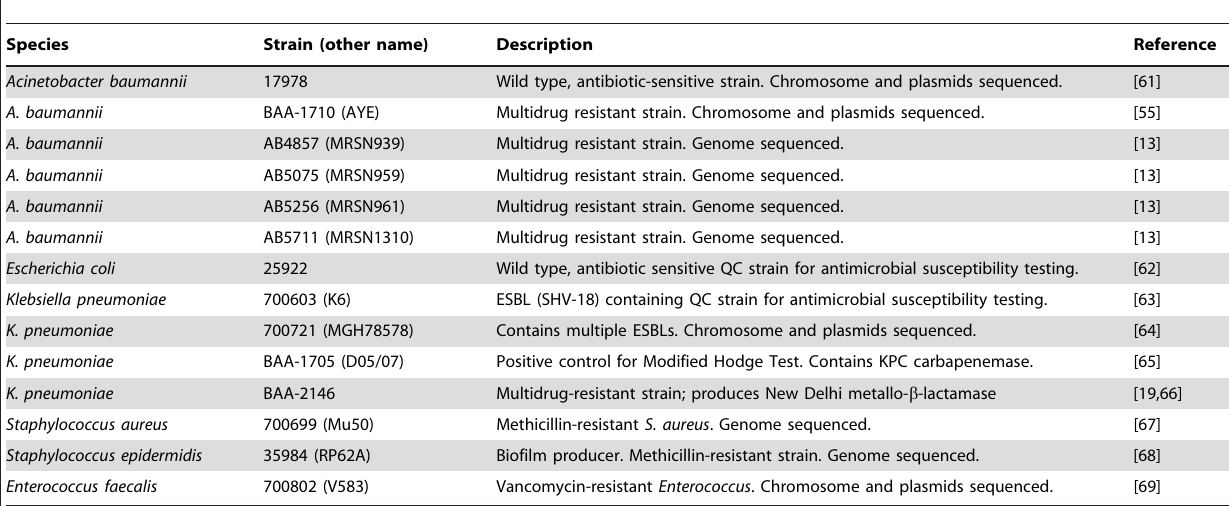
Table 1. Reference strains used for confirmation of the ARDM content.